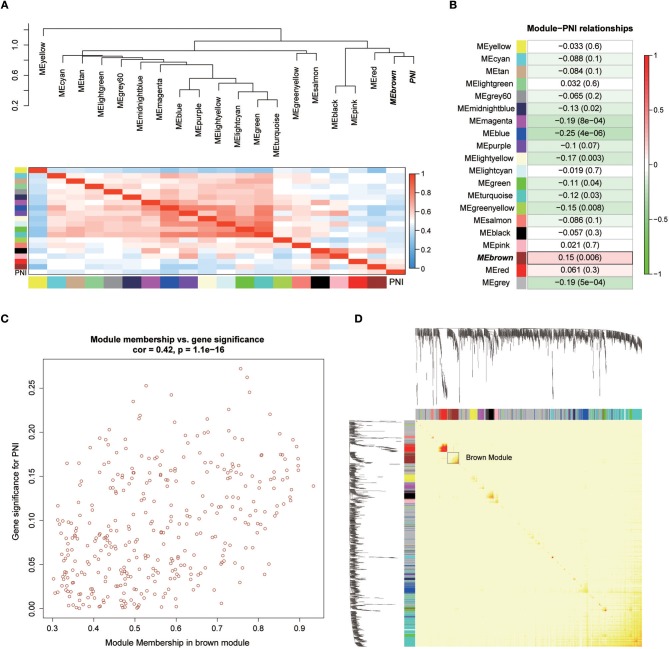
(A) Correlations between the modules. (B) Correlation values for different module-PNI relationships. (C) Scatter plot of the correlation between gene MM in the brown module, which was associated with PNI, and gene significance for PNI. (D) Network heatmap plot showing genes sorted into rows and columns by the clustering tree. Lighter colors denote lower adjacency, and darker colors denote higher adjacency.